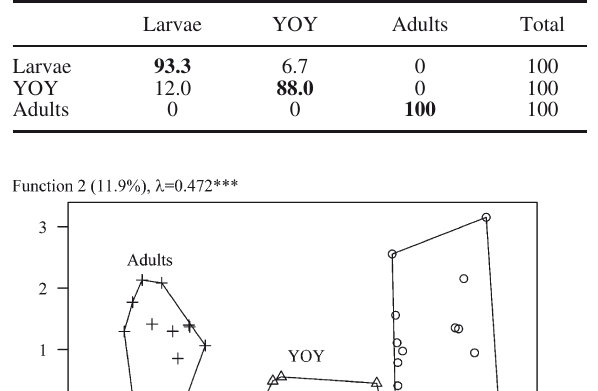
Table 5. – Percentage success rate reclassifying sole to life stage us- ing a cross-validated CDA and whole otolith elemental ratios. Rows represent actual groups while columns represent predicted groups. Correct classifications are given in bold characters; YOY, young of the year.